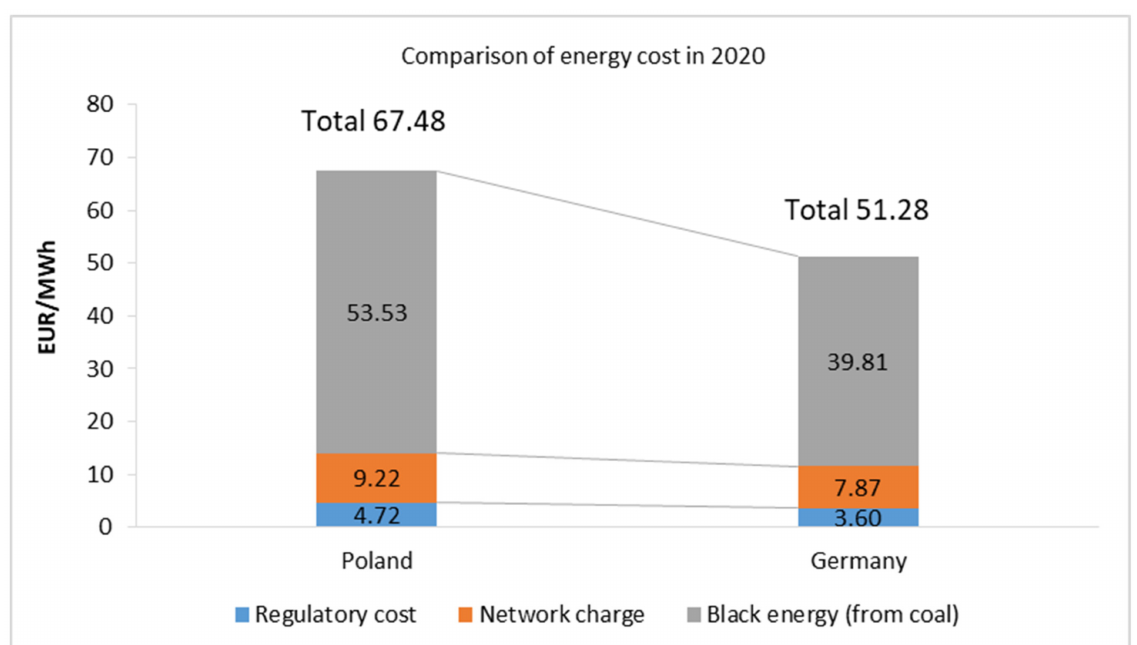
Figure 10. Comparison of energy cost: Poland and Germany [EUR/MWh] in 2020. Source: own elaboration based on